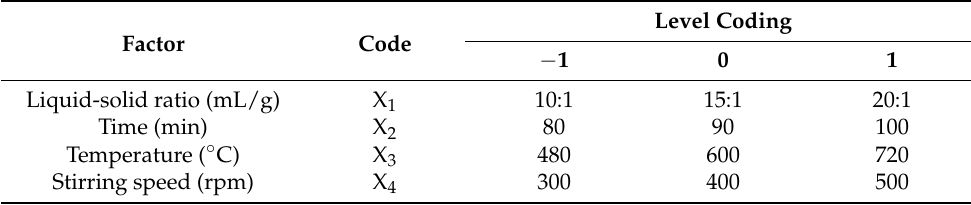
Table 2. Experimental factor values and level coding.